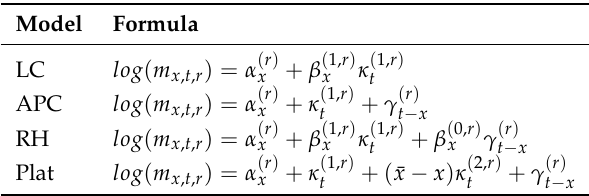
Table 1. Mortality models for the reference